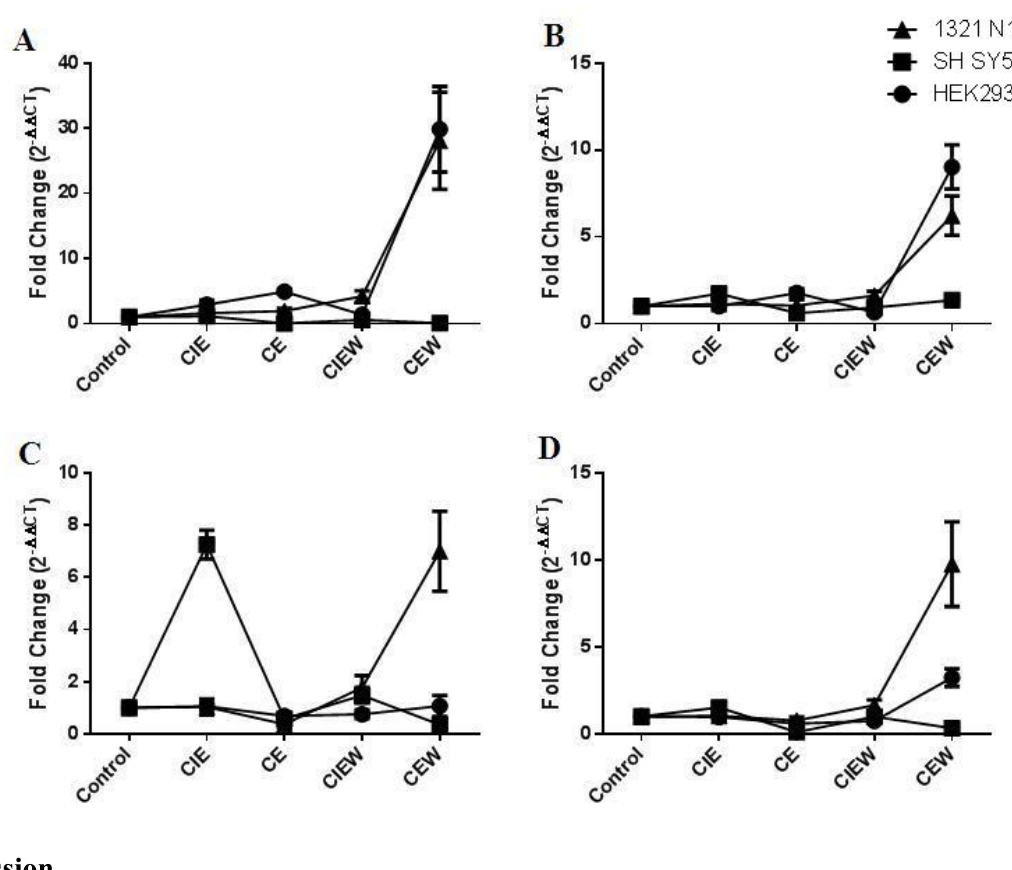
Figure 1. The pattern of expression of miRNAs following ethanol treatment. ( A ) miR-7; ( B ) miR-152; ( C ) miR-153 and ( D ) miR-15B. Data is plotted as mean ±